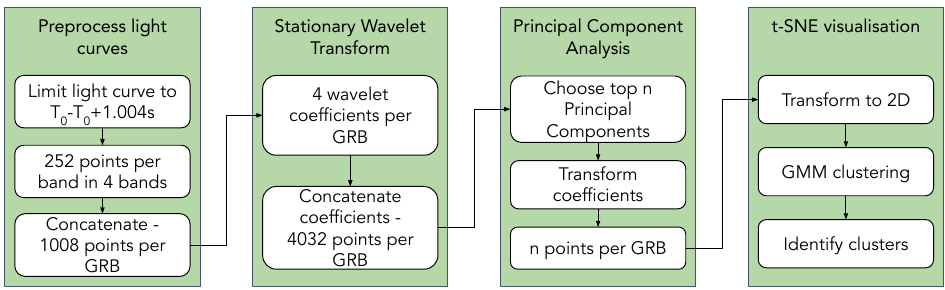
Figure 2. Flowchart of the feature extraction and clustering algorithm for analysis of light curves in the interval T 0 to T 0 +